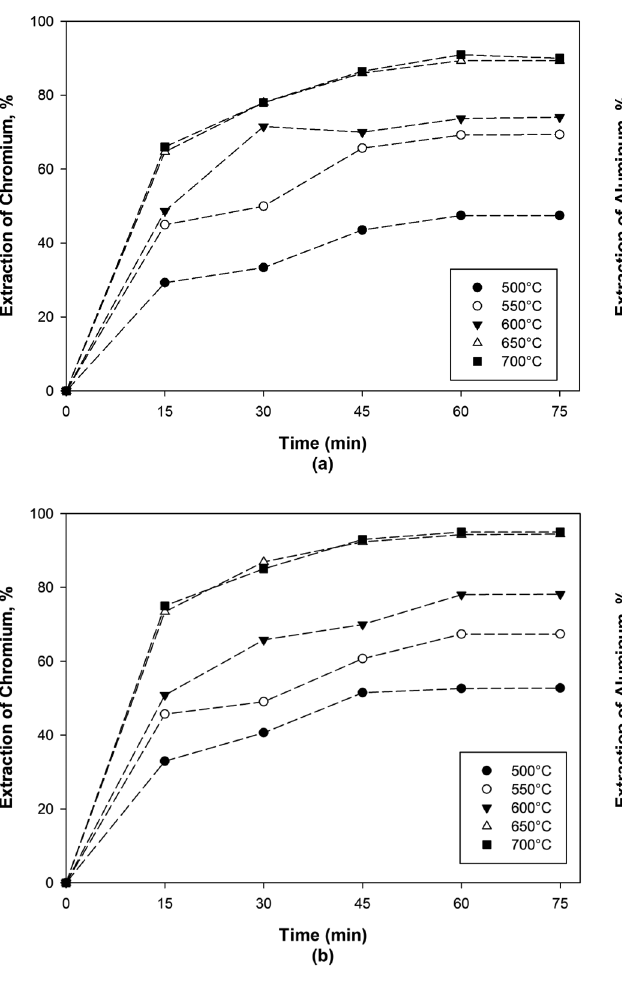
Fig. 6: The effect of time on the conversion percentage of chromium: (a) 2 g of NaOH, (b) 4 g of NaOH (1 g conc.)